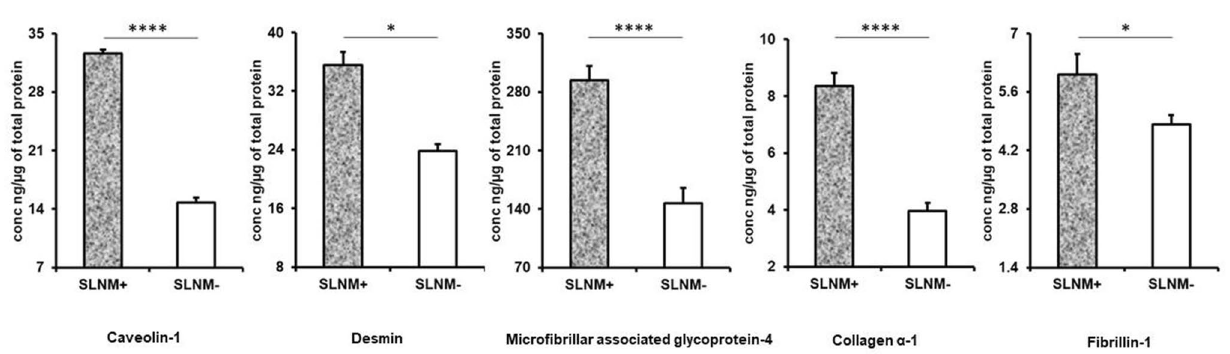
Figure 5. KEGG pathways analysis and Gene Ontology of differentially expressed proteins. ( a ) KEGG pathway analysis showing the various possible pathways regulated by the differentially expressed proteins; ( b ) Gene Ontology for cellular components showing distribution of 49 up-regulated proteins across various cellular organelles; ( c ) Gene Ontology for cellular components showing distribution of 60down-regulated proteins across various cellular organelles. Square boxes designate the FDR corrected p-values.